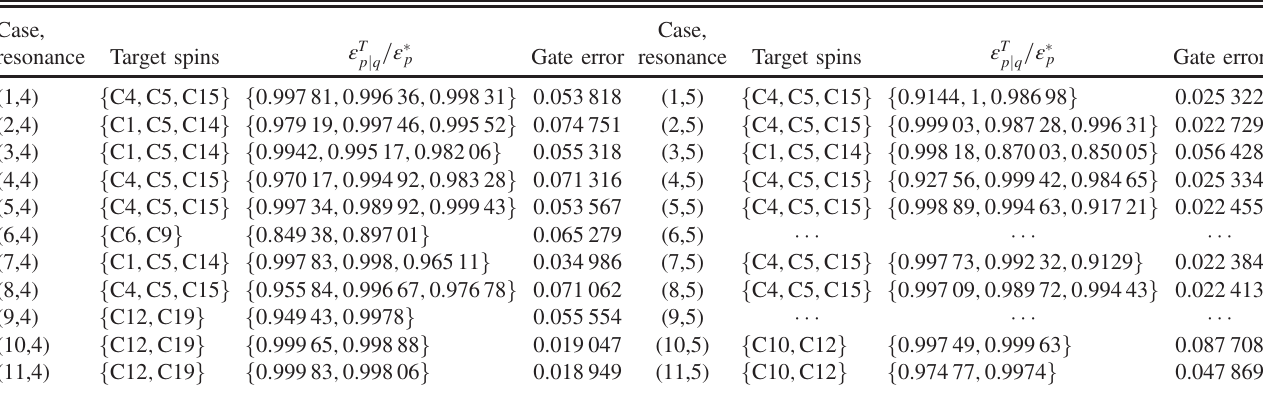
TABLE IX. Target spins, one-tangles, and gate error for each case number for the k ¼ 4 and k ¼ 5 resonance in Fig. 8. Case,